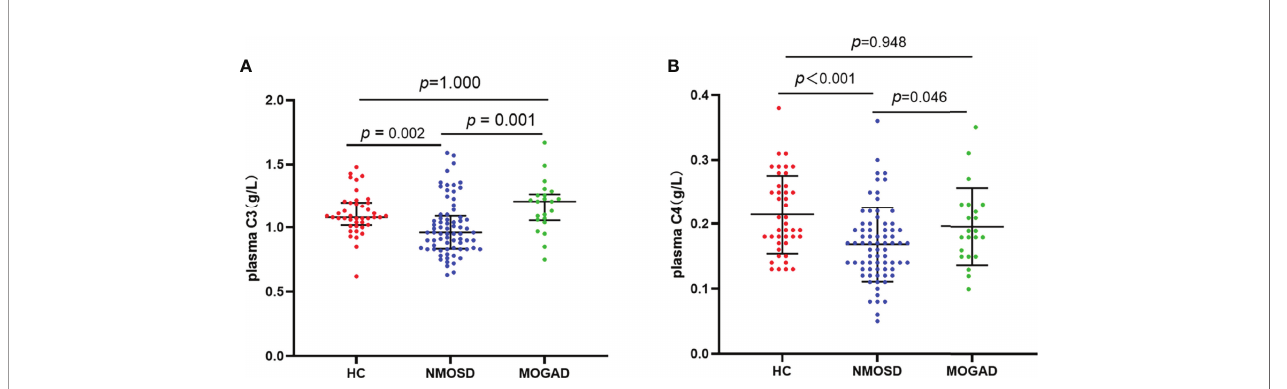
FIGURE 1 | Plasma levels of C3 (A) and C4 (B) in heathy control, AQP4-IgG positive NMOSD, and MOGAD. Results are presented as scatter plots with the median and interquartile range (IQR). The statistically signi fi cant differences were analyzed using the Kruskal-Wallis-test and the corrected p-values using the Bonferroni. C3,